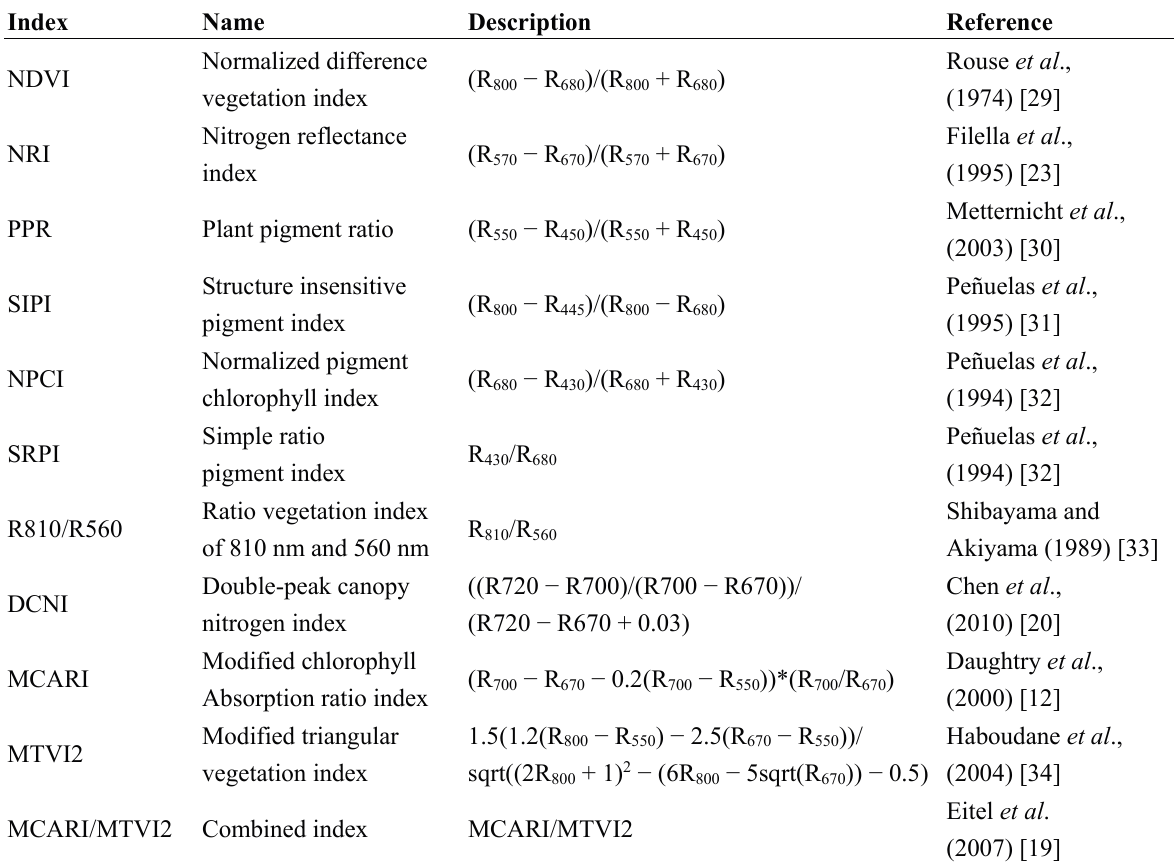
Table 1. Vegetation indices analyzed in this study.